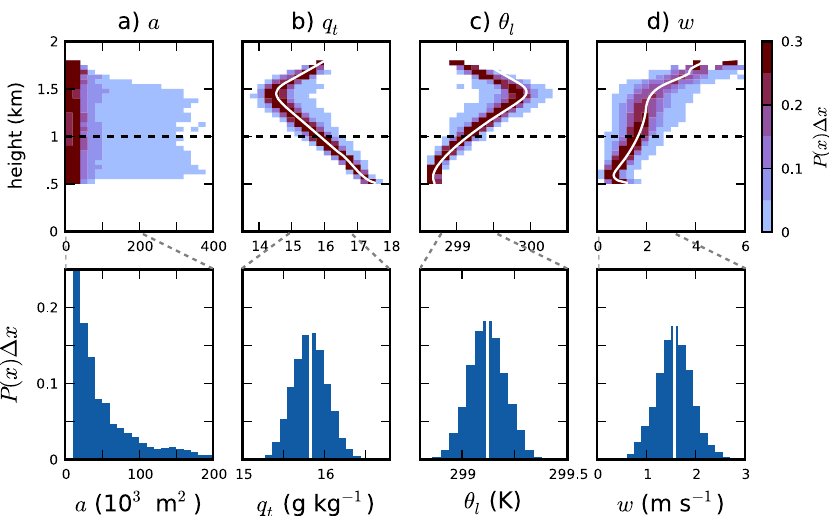
Fig. 3. Probabilities in range 1x ( P(x)1x ) at each model height (top row) and at 1km height (bottom row) for cloud core (a) cross-sectional area, (b) total specific humidity, (c) liquid-water potential temperature, and (d) vertical velocity in the BOMEX LES output. White lines indicate the horizontal mean of each variable conditionally sampled on the cloud core over the entire model domain.